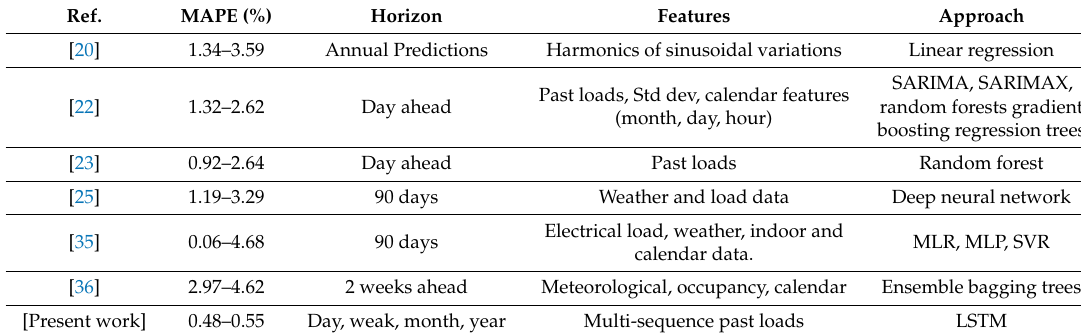
Table 8. Reviewed Papers for features and